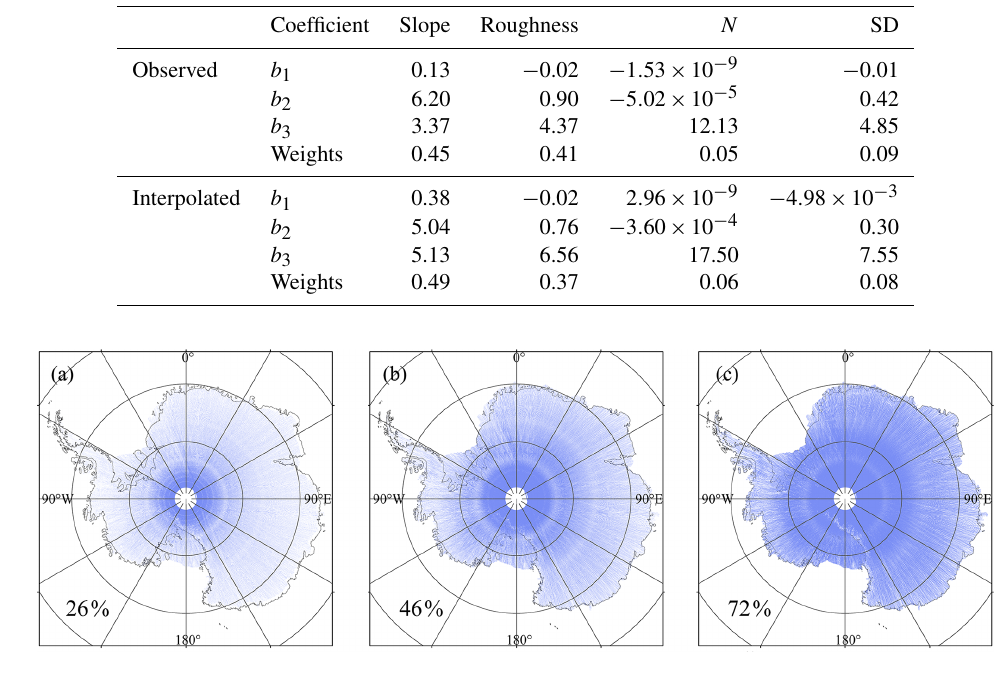
Figure 3. Maps of the observed grid cells of DEMs at the spatial resolution of 250m (a) , 500m (b) and 1km (c) . The observed grid cells are coloured in blue and the overall coverage of each DEM in Antarctica is also included.